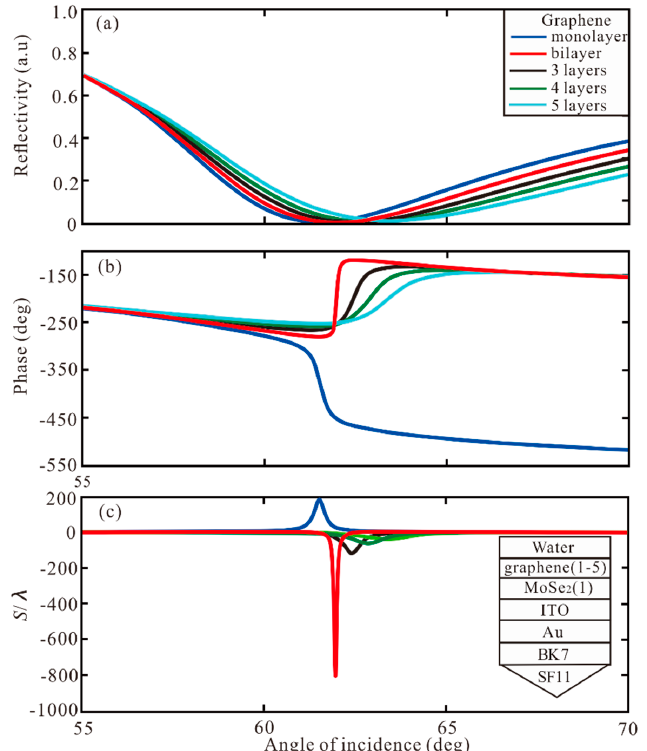
Figure 5. The change of ( a ) reflectivity, ( b ) phase, and ( c ) GH shift with respect to angle of incidence for different number of graphene layers with monolayer of MoSe 2 .